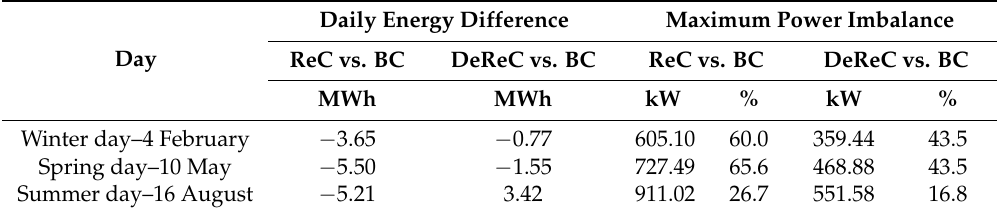
Figure 9. Hourly based curves for DEGS supplied power in BC (black line), ReC (green line) and DeReC (blue line) for three specific days: ( a ) 4 February, ( b ) 10 May ( c ) 16 August. Table 6. DEGS supplied power maximum imbalance data for ReC and DeReC with respect to BC in three specific days.